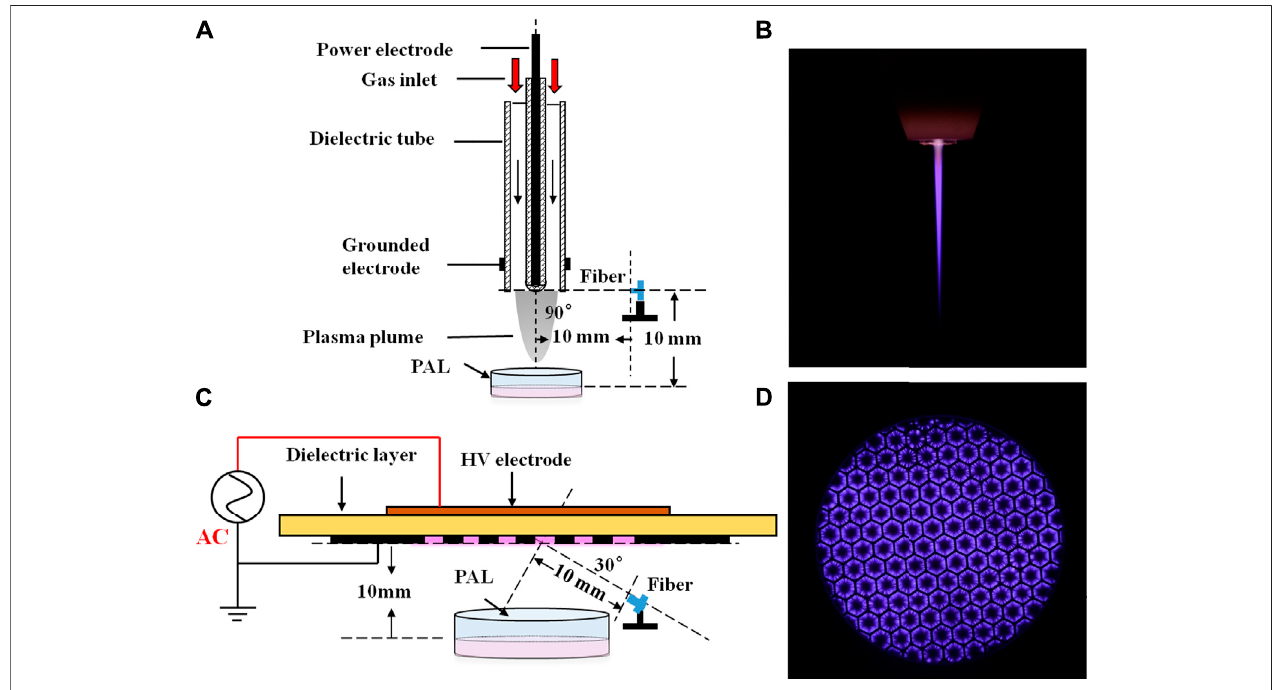
FIGURE 1 | Low temperature plasma jet/surface at atmospheric pressure. (A) Structure and (B) photograph of the plasma jet device; (C) structure and (D) photograph of the plasma surface device.